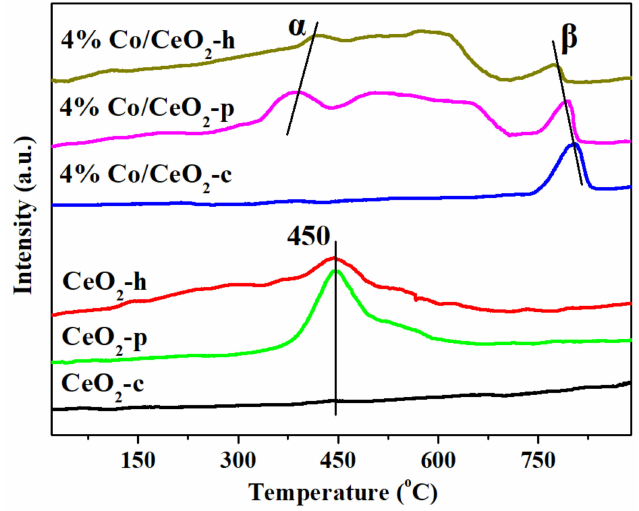
Figure 10. O 2 -TPD profiles of CeO 2 supports and 4% Co / CeO 2